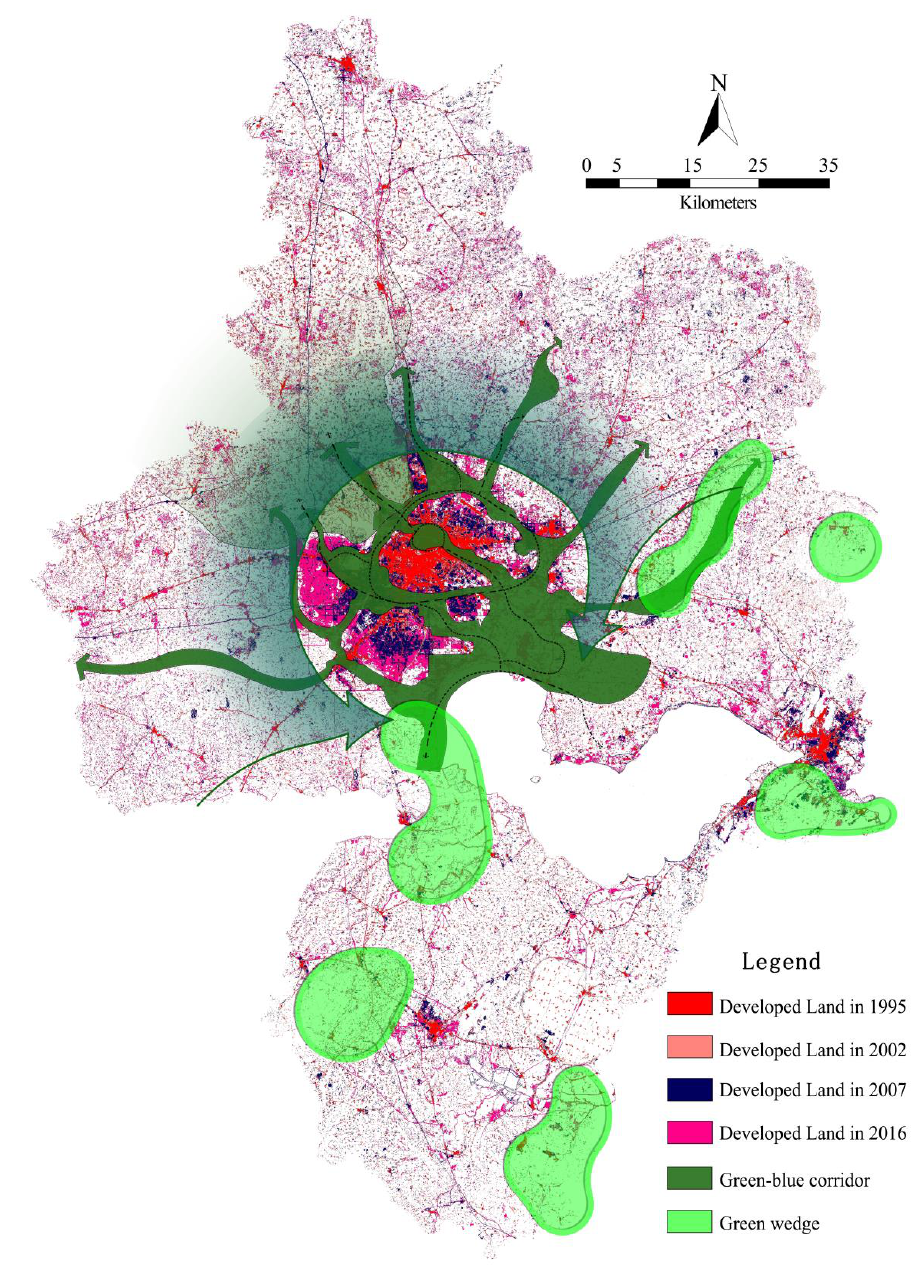
Figure 6. Proposed ecological network framework for mitigating the SUHI effect.